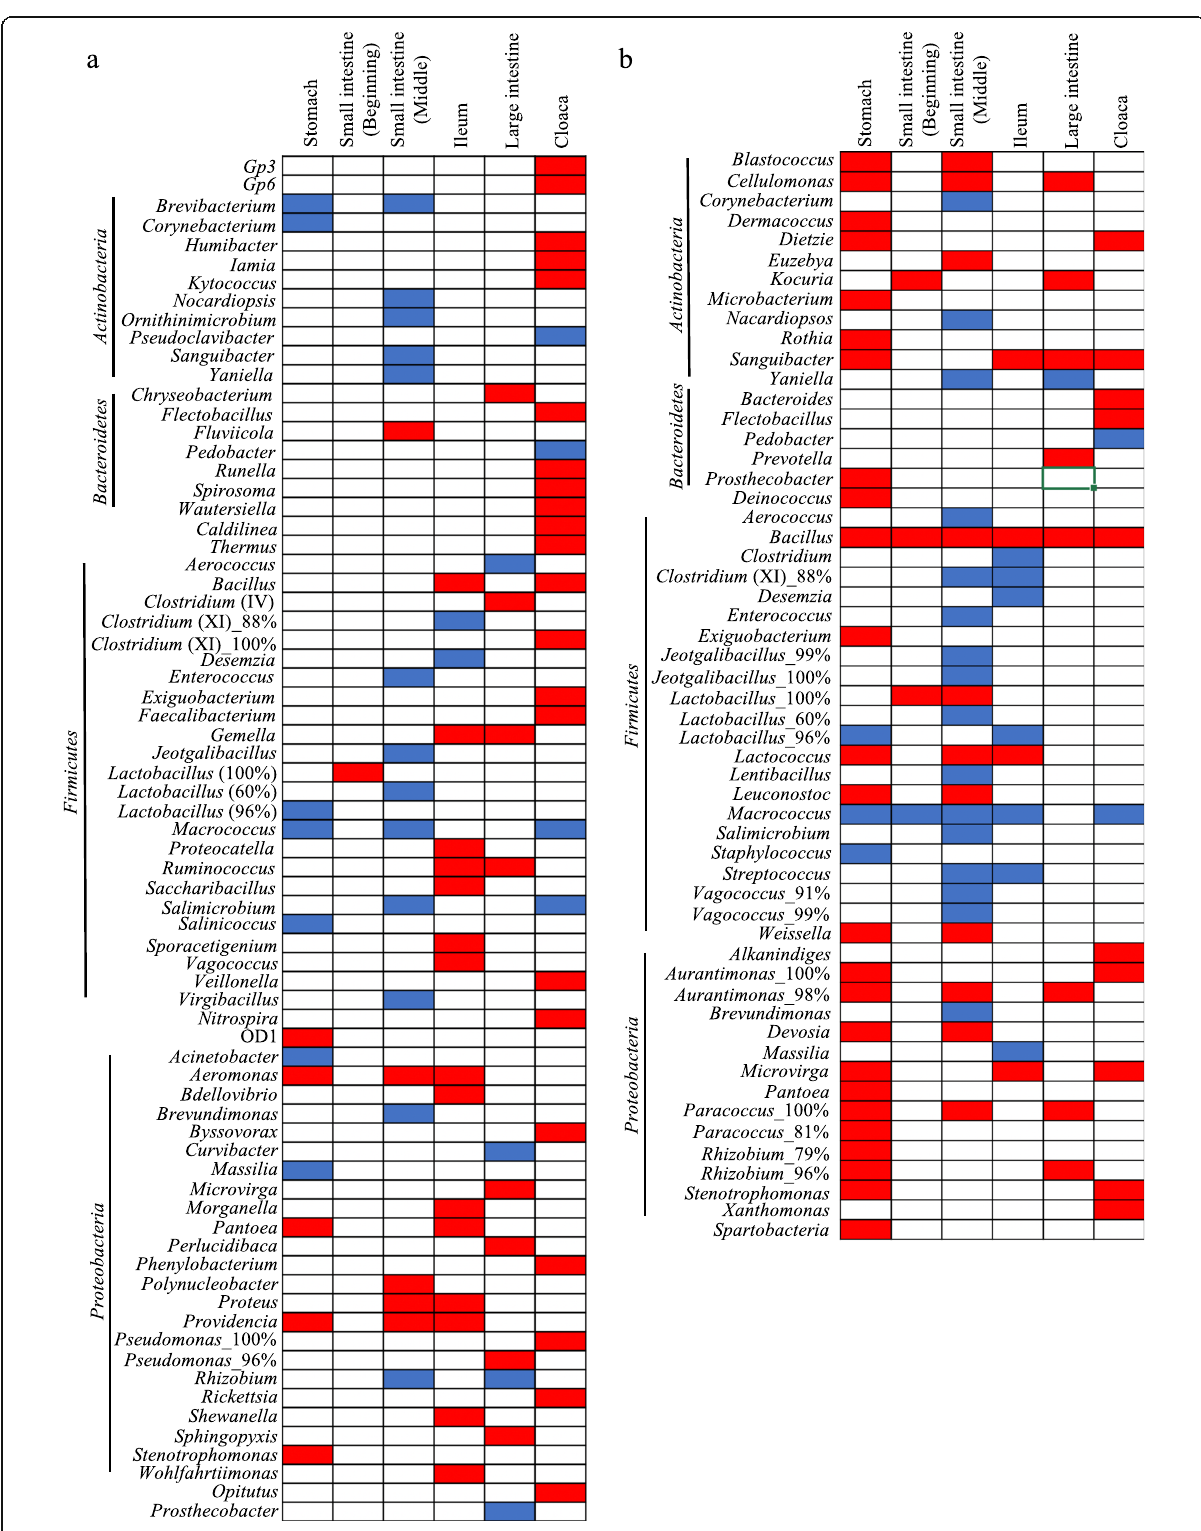
Fig. 6 Differentially abundant bacterial taxa at the genus level between different gut sections of ( a ) fresh and two-weeks old and ( b ) fresh and two-months old alcohol specimens. Blue indicates that the taxon was significantly more abundant in fresh samples, and red that the taxon was significantly more abundant in alcohol samples. The figure only represents taxa identified to the genus level (Additional file 4: Table